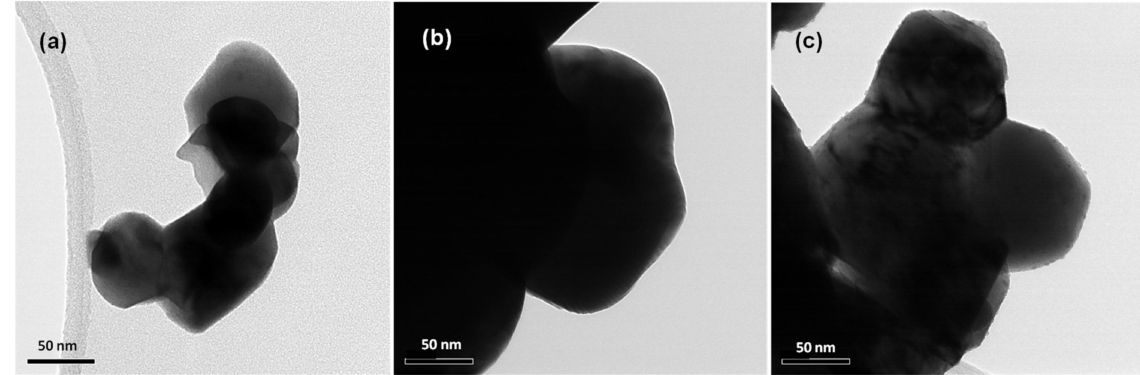
Figure 3. TEM images of ( a ) NFT, ( b ) NAT, and ( c ) NNT.